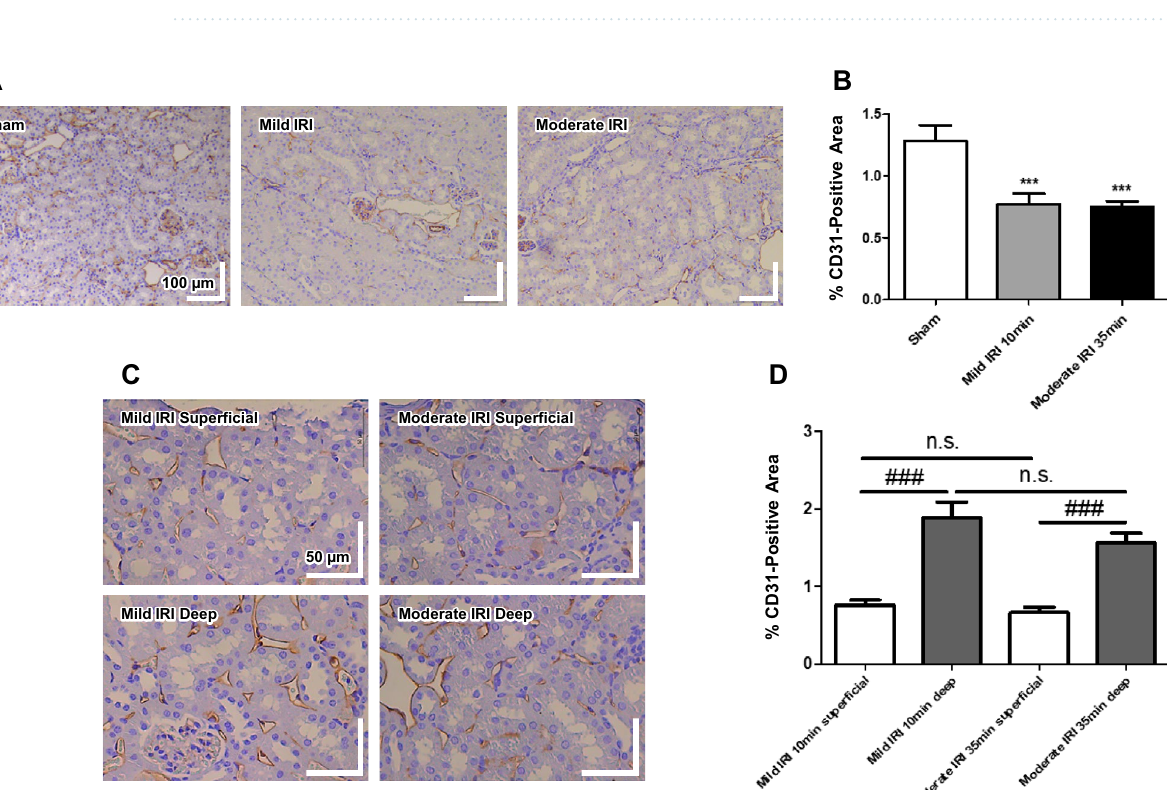
Figure 7. Immunohistochemical staining of CD31 in renal ischemia–reperfusion injury models 7 weeks after ischemia. ( A , B ) Immunohistochemical staining of CD31 was significantly decreased in the long-depth-range sections (200 ×) of both the mild IRI (10-min) and the moderate IRI (35-min) groups. ( C , D ) Quantitative analysis of smaller sections (400 ×) showed that CD31 was significantly more decreased in the superficial layer than in the deep layer. Data represent mean ± SEM. *** p < 0.001 vs. sham; ### p < 0.001 vs. deep layer; n. s. not significant. The differences among the groups were analyzed using a one-way nonparametric ANOVA followed by Tukey’s multiple comparison